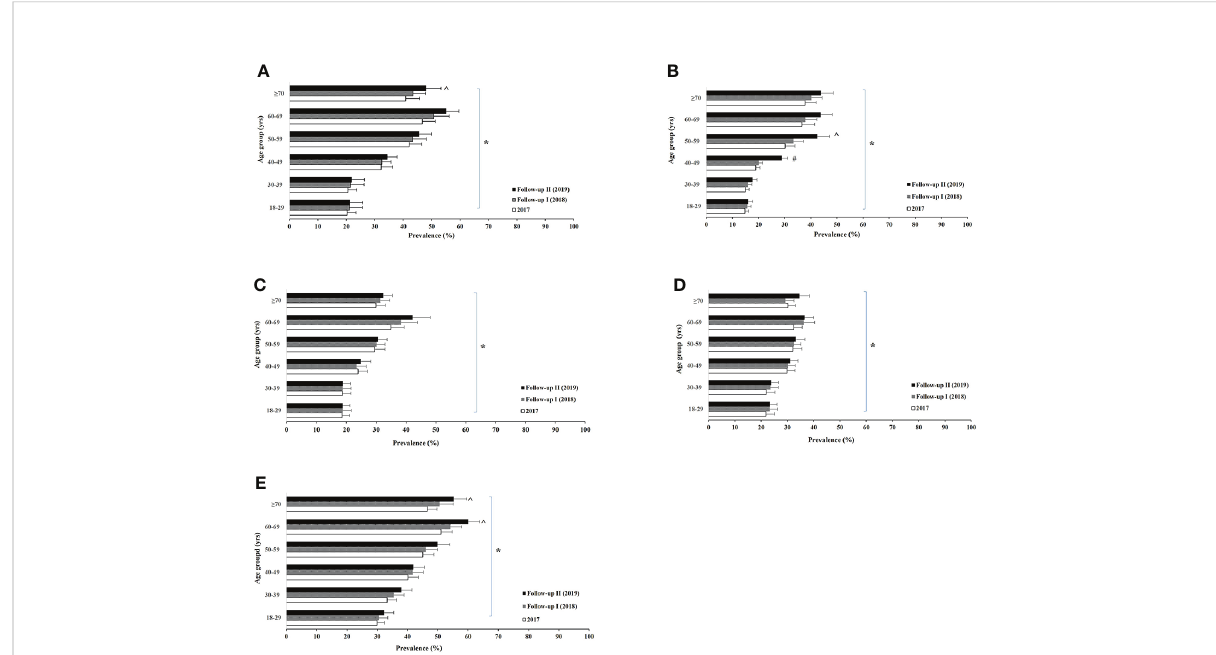
FIGURE 1 Male age-speci fi c prevalence of high total (non-HDL) cholesterol (A) , high low-density lipoprotein cholesterol (B) , low high-density lipoprotein (C) , high triglyceride (D) , and dyslipidemias (E) among urban adults in East Coast, Fujian, China between 2017 and 2019. Logistic regression analysis indicated: * aging trend within each lipid abnormality (A) p < 0.005; (B) p < 0.001; (C) p < 0.001; (D) p = 0.003; (E) p < 0.001, and ^ for time trend within the age group (B) p <